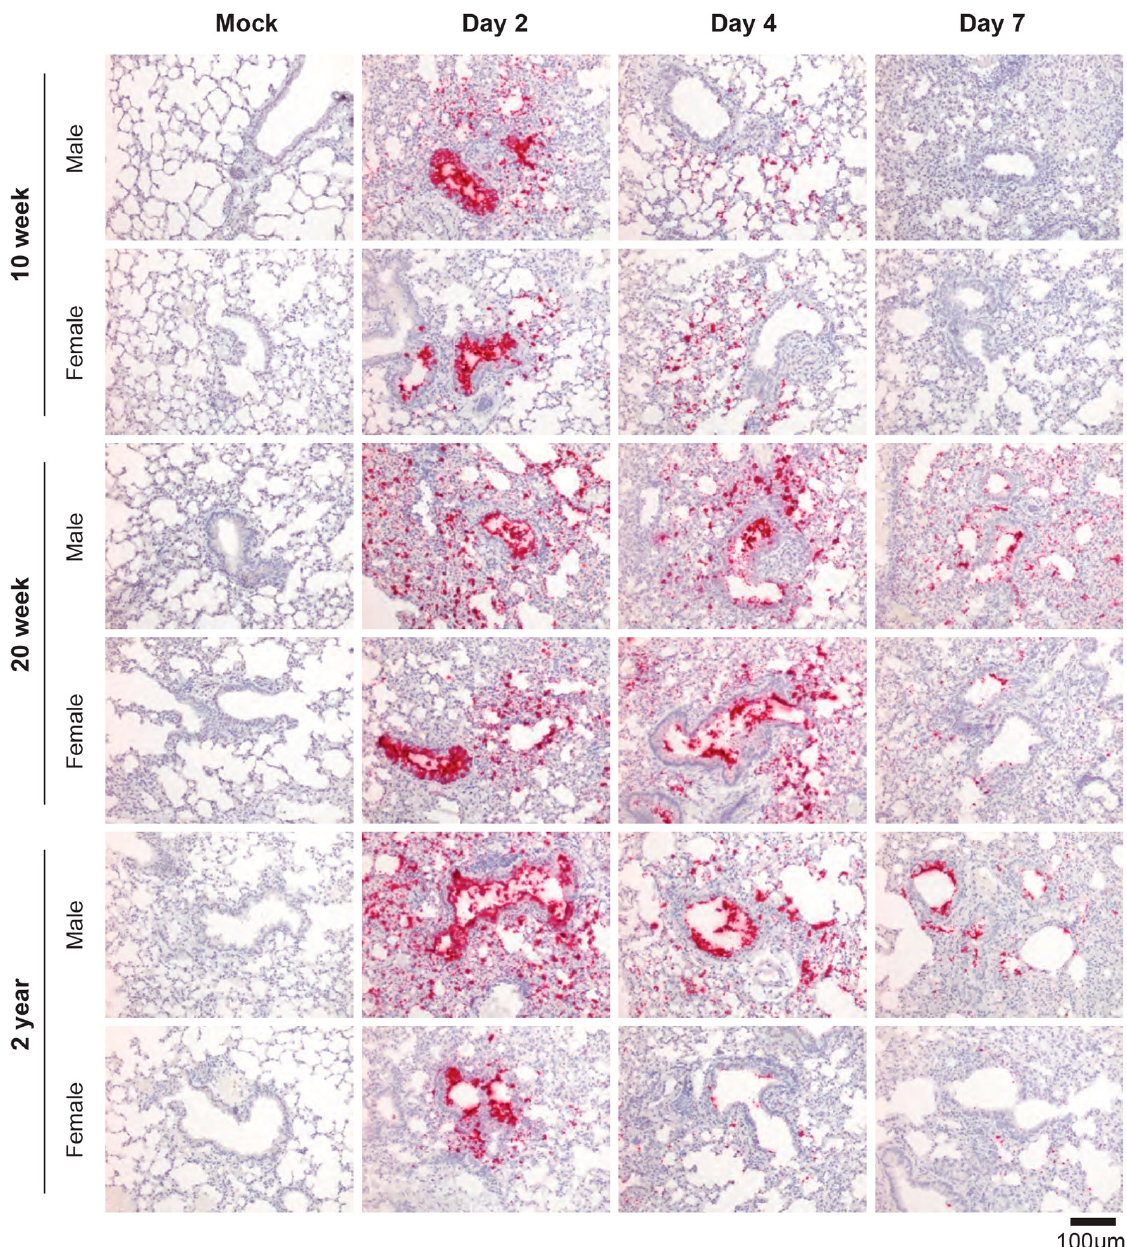
Figure 5. SARS-CoV-2-specific RNA-ISH of 10 wk-old, 20 wk-old, and 2 yr-old mice infected with R2G. Formalin-fixed, paraffin-embedded (FFPE) tissue sections were stained for the sense strand of spike as in Figure 1C. Tissue was collected either 2, 4, or 7 days post infection or 7 days post mock infection from the 10 wk-, 20 wk-, and 2 yr-old male and female mice discussed in Figure 4, and quantitation of air space involvement can be found in Supplemental Figure S9.